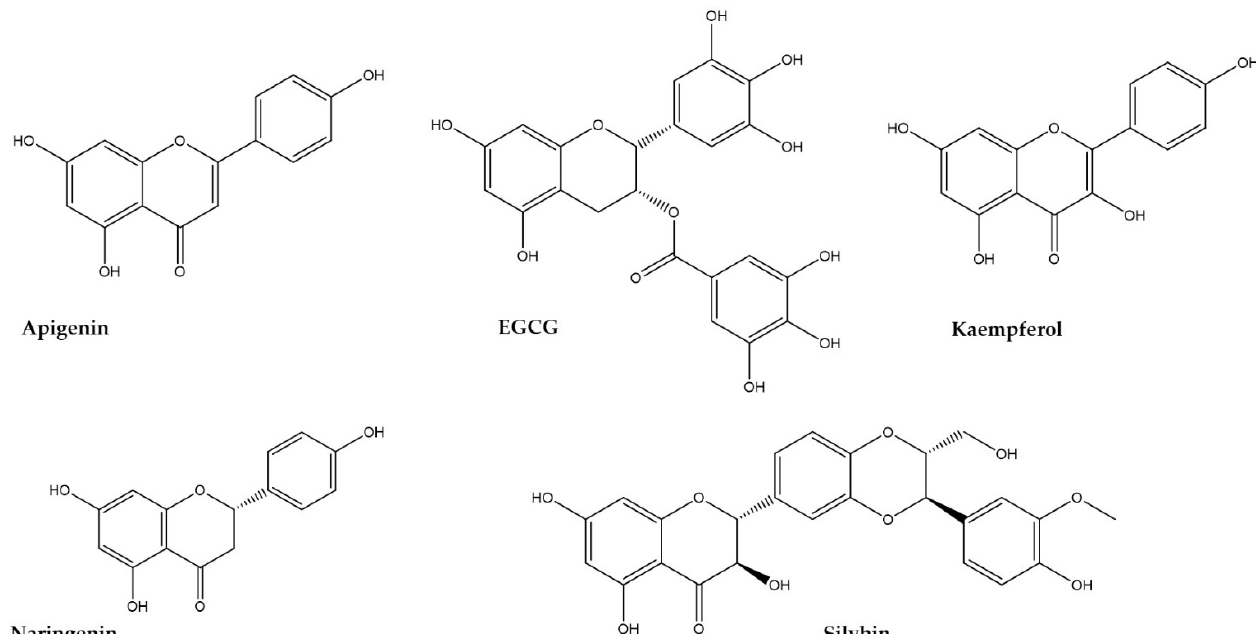
Figure 2. The chemical structure of the five flavonoids selected in this review, namely, apigenin (flavone), epigallocatechin-3-gallate (EGCG, catechin), kaempferol (flavonol), naringenin (flavanone), and silybin (flavonoid derivative).